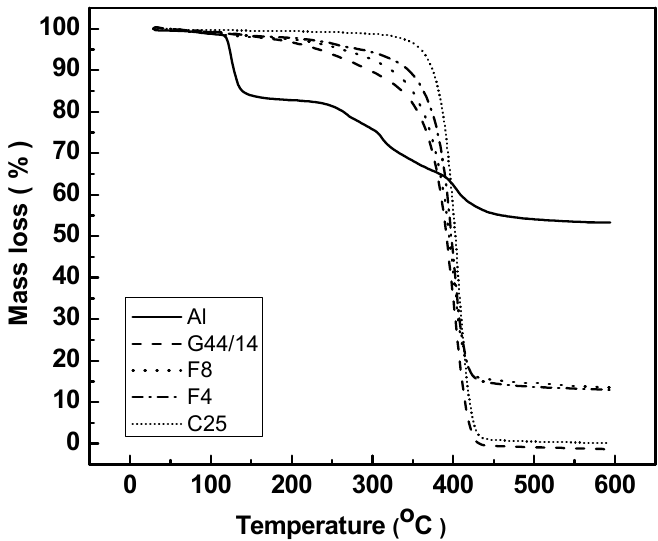
Figure 3. Comparative graphic representation of weight loss for AL-loaded SLPs in F4 and F8 formulations and their ingredients.